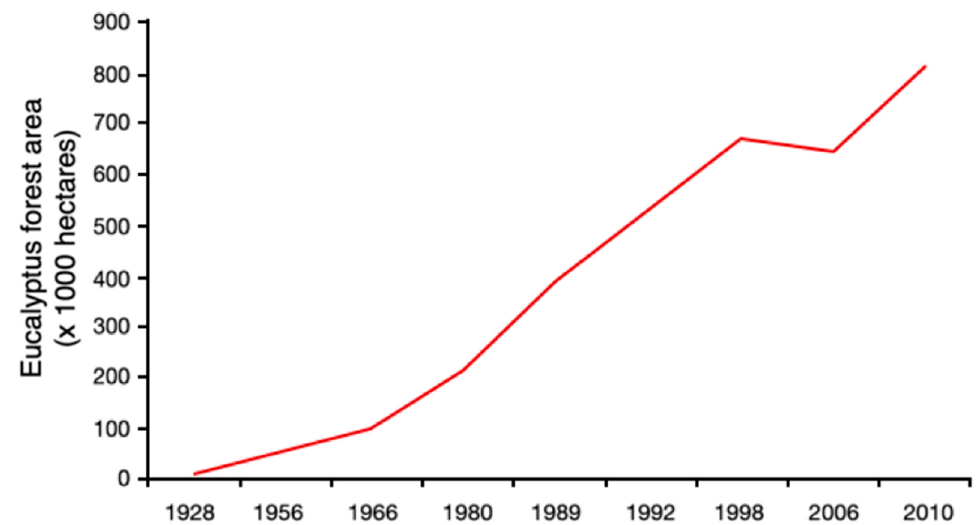
Figure 7. Changes in the area covered by eucalyptus in mainland Portugal (adapted from [57]).